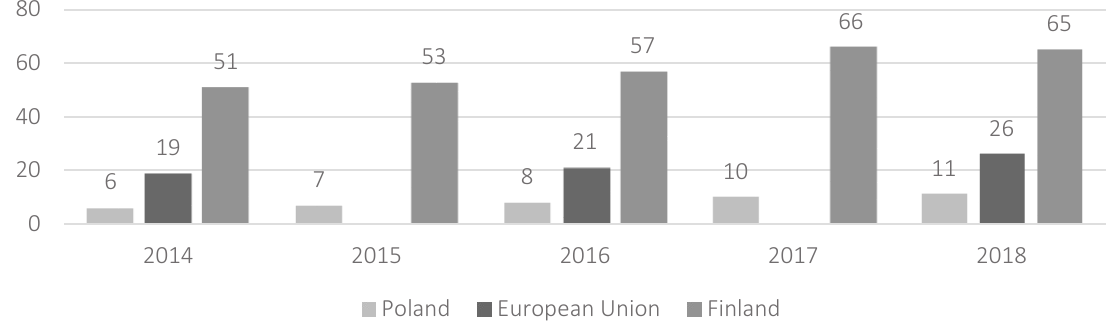
Figure 2. Percentage of enterprises that bought cloud computing services “7. Information and communication” (44%), “11. ICT sector” (41%), and “9. Professional, scientific and technical activities” (22%). Minimum values were ob- served for “3. Construction” (6%), “5. Transportation and storage” (9%), and “1. Manufacturing” and Table 1. Types of business